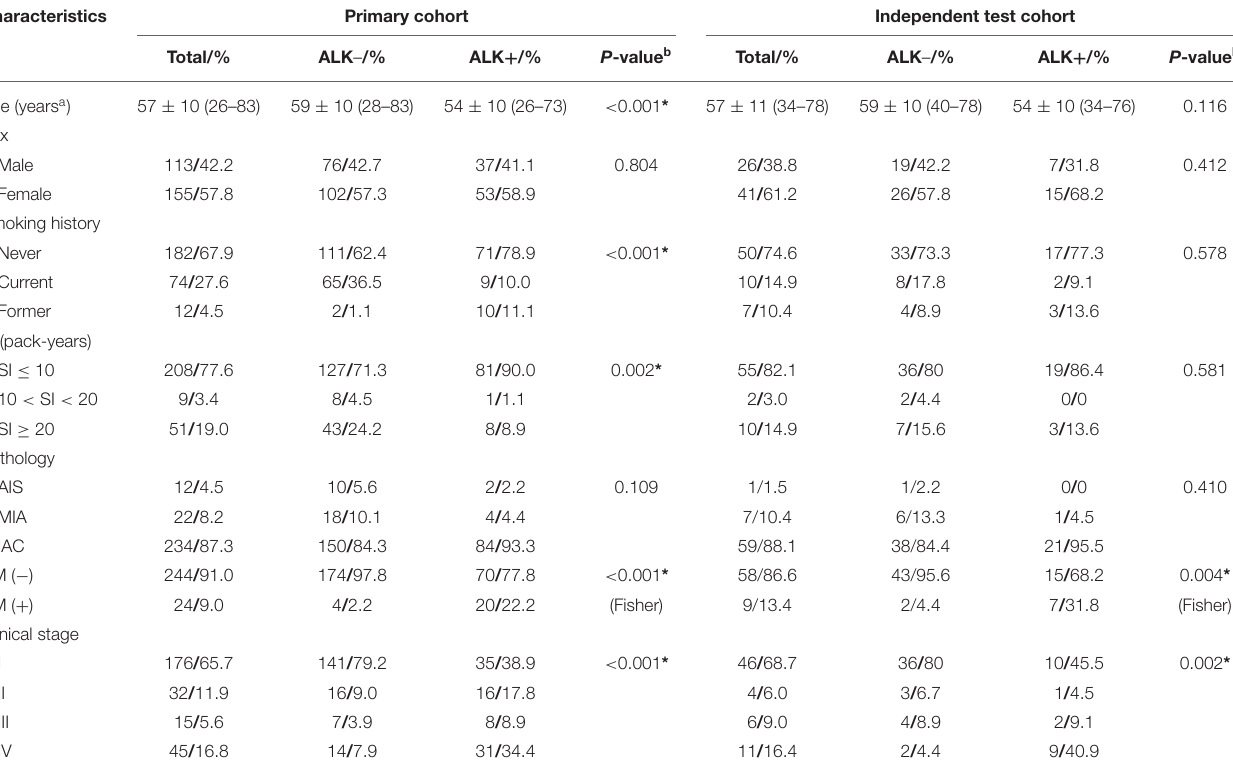
TABLE 1 | Clinical characteristics of ALK– and ALK + lung adenocarcinoma patients in the primary and test cohort.